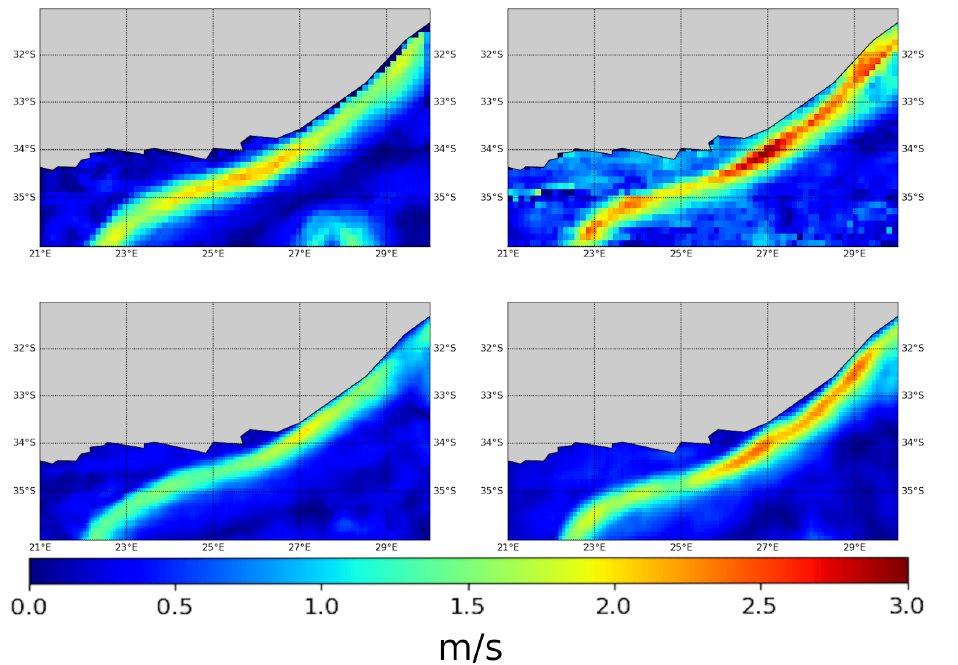
Figure 6. Reconstructed velocity fields for 16 January 2016: Top left : AVISO, top right : AIS-OI, bottom left proposed scheme using only AIS data during the training phase (VAE-NODE-AIS), bottom right : proposed scheme using AIS and GLORY during the training phase (VAE-NODE-